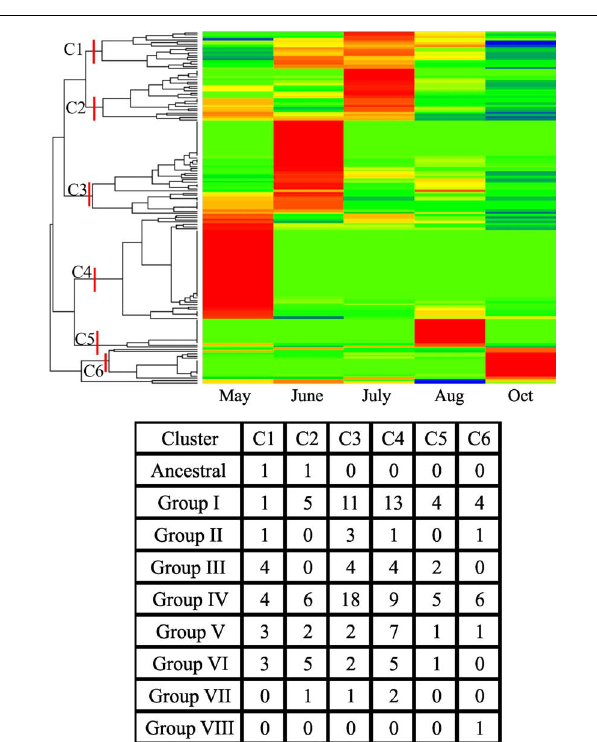
in these datasets. Roots = Rt; Shoot = Sh; Flowers = Fwr. Red indicates high abundance, yellow is intermediate and green and blue are low or negligible abundance.The appropriate SRA identification numbers for these individual NGS files are shown in TableA1 in Appendix.